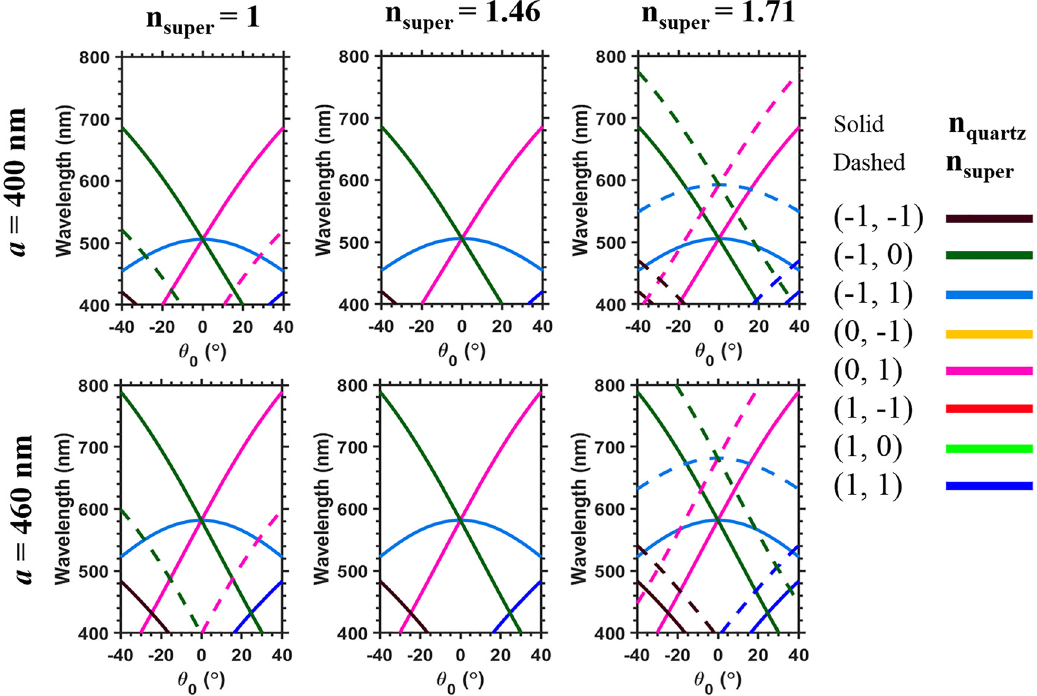
Figure S5: Lattice modescalculated from Eq.(7) with n super =1, 1.46, and 1.71(in column)and a =400 and460 nm (in row)as a functionof θ 0 . The latticemodesinthesubstrateenvironment ( n = n quartz inEq.(7))aredenotedbysolid lines,whiletheonesinthesuperstrateenvironment ( n = n super in Eq. (7)) are denoted by dashed lines. The corresponding orders are color-coded and plotted in the right. Note that the modes (0, − 1), (1, − 1), and (1, 0) overlap with modes (0, 1), ( − 1, 1), and ( − 1, 0), respectively.